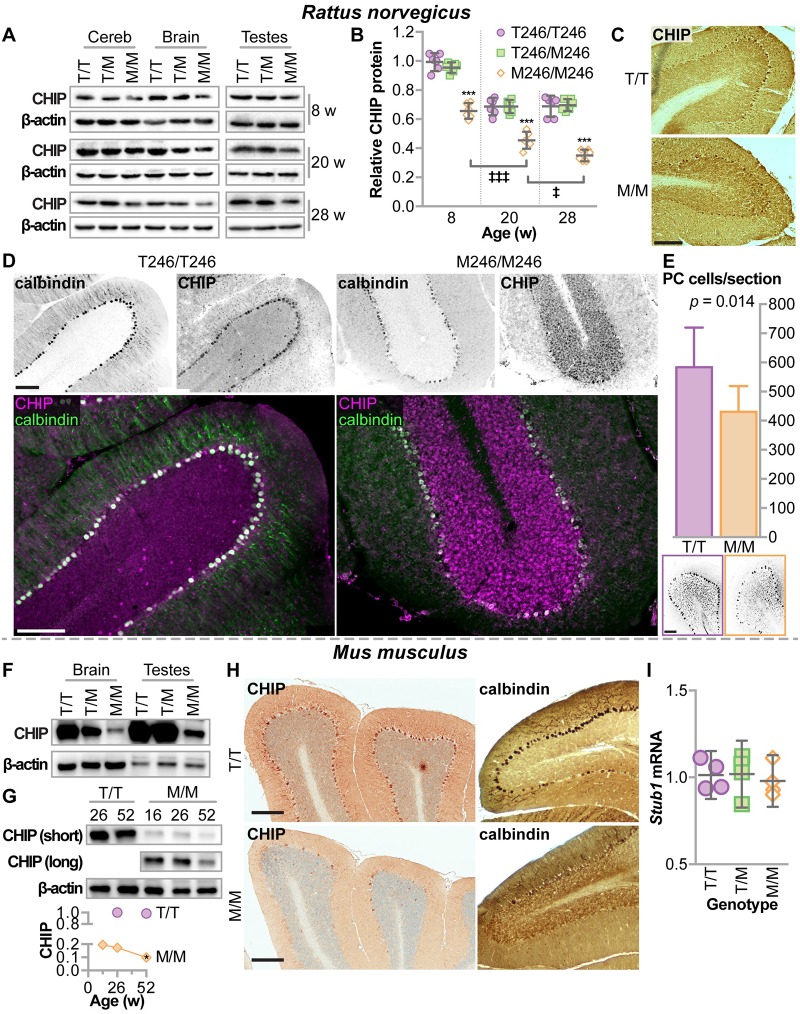
Rodents engineered with CHIP-T246M had decreased expression of CHIP in the brain and testes, Purkinje cell degeneration, increased mortality, and selective tissue atrophy.(A) Immunoblot analysis of CHIP and β-actin in the cerebellum (cereb), brain, and testes of rats with either T246/T246 (T/T), T246/M246 (T/M), or M246/M246 (M/M) genotypes at harvested at different ages. (B) Densitometry analysis of relative CHIP protein represented by dot plot and summarized by the mean ± 95% CI: *** p < 0.001 compared to T/T or T/M; ‡, ‡‡‡ correspond to p < 0.05, or 0.001 compared to previous time point via Tukey’s post hoc test. (C) Representative micrographs of immunohistochemical detection of CHIP expression in rat cerebellums, 32 weeks of age, scale bar = 100 microns. (D) Indirect immunofluorescence of either calbindin or CHIP expression and the false color overlap (co-expression) in cerebellums of rats with the indicated genotypes, 32 weeks of age, scale bar = 100 microns. (E) Average number of Purkinje cells per section from rats at 32 weeks of age, summarized by the mean and 95% CI, N = 3 animals per genotype. Immunoblot analysis of CHIP in (F) brain and testes (26 weeks of age) or (G) cerebellum of mice of varying age, with the indicated genotypes. Densitometry analysis of relative CHIP protein levels, N = 3, * p < 0.05 via t-test in comparing CHIP in M/M mice at 52 versus 26 weeks normalized to stain-free protein levels. (H) Representative micrographs of immunohistochemical detection of either CHIP or calbindin expression in mouse cerebellums with the indicated genotypes, 52 weeks of age, scale bar = 200 microns. (I) qPCR analysis of Stub1 mRNA levels in four different tissues (heart, liver, brain, testes) isolated from mice with the indicated genotypes, N = 3 mice per tissue. Relative mRNA levels are represented by the dot plot and summarized by the mean and 95% confidence intervals.